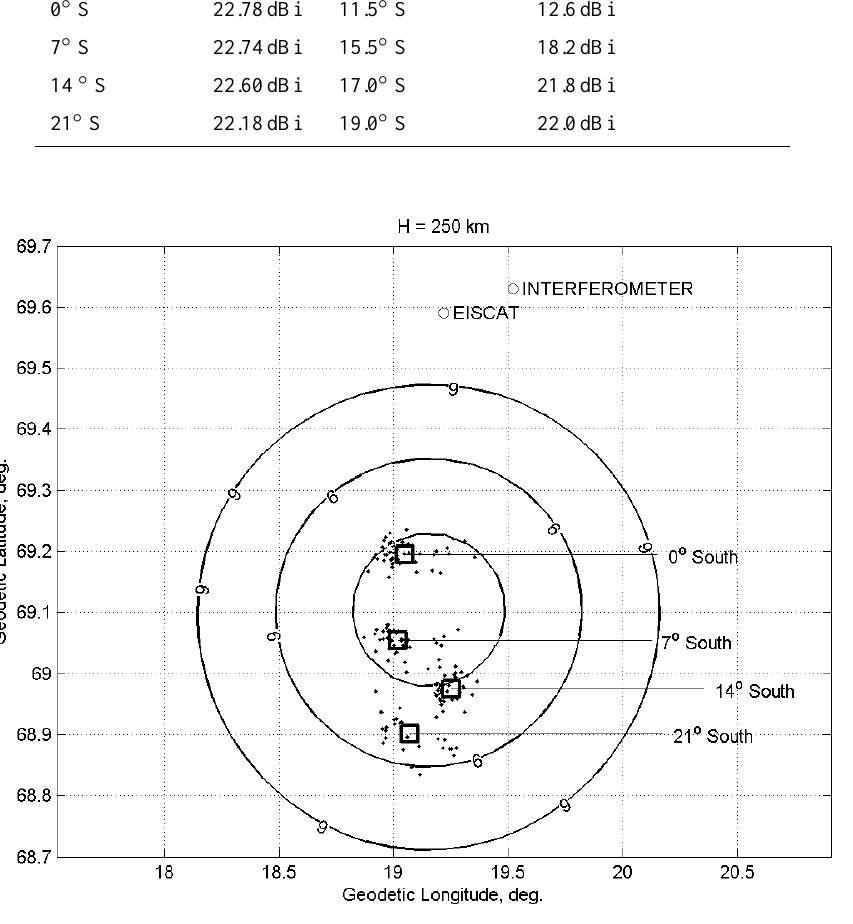
Fig. 8. Intensity-weighted average locations of the downshifted peak (DP) source region estimated from the phase difference angles (dots) are shown along with contours of the angle between the pump beam direction and the geomagnetic field at 250km (solid lines). The squares show the mean positions of the DP for each of the HF beam directions while the labels indicate the corresponding pump beam pointing. 0 ◦ south (i.e. vertical) pump beam pointing began at 15:30 UT, 7 ◦ south at 15:34 UT, 14 ◦ south at 15:38 UT, and 21 ◦ south at 15:42 UT. The average location varied from about 2.5 ◦ north to 5 ◦ south of magnetic zenith (located at the center of the contour circles), with the three positions closest to field-aligned having the strongest signal intensities (see Fig. 6). Note also the approximately 1.5 ◦ eastward offset of the weighted DP source region position for pump pointing near magnetic field-aligned (14 ◦ south) as compared to the other beam